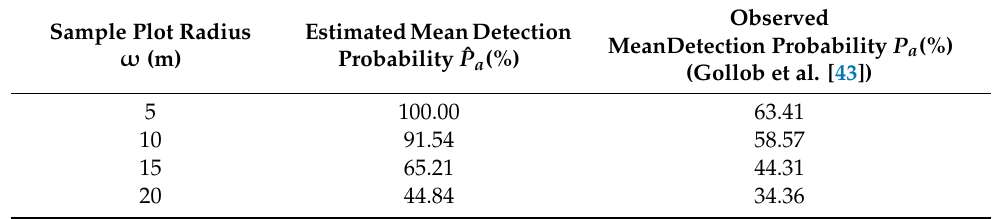
Table 2. Estimated and observed mean detection probabilities for different sample plot radii using classic distance sampling.